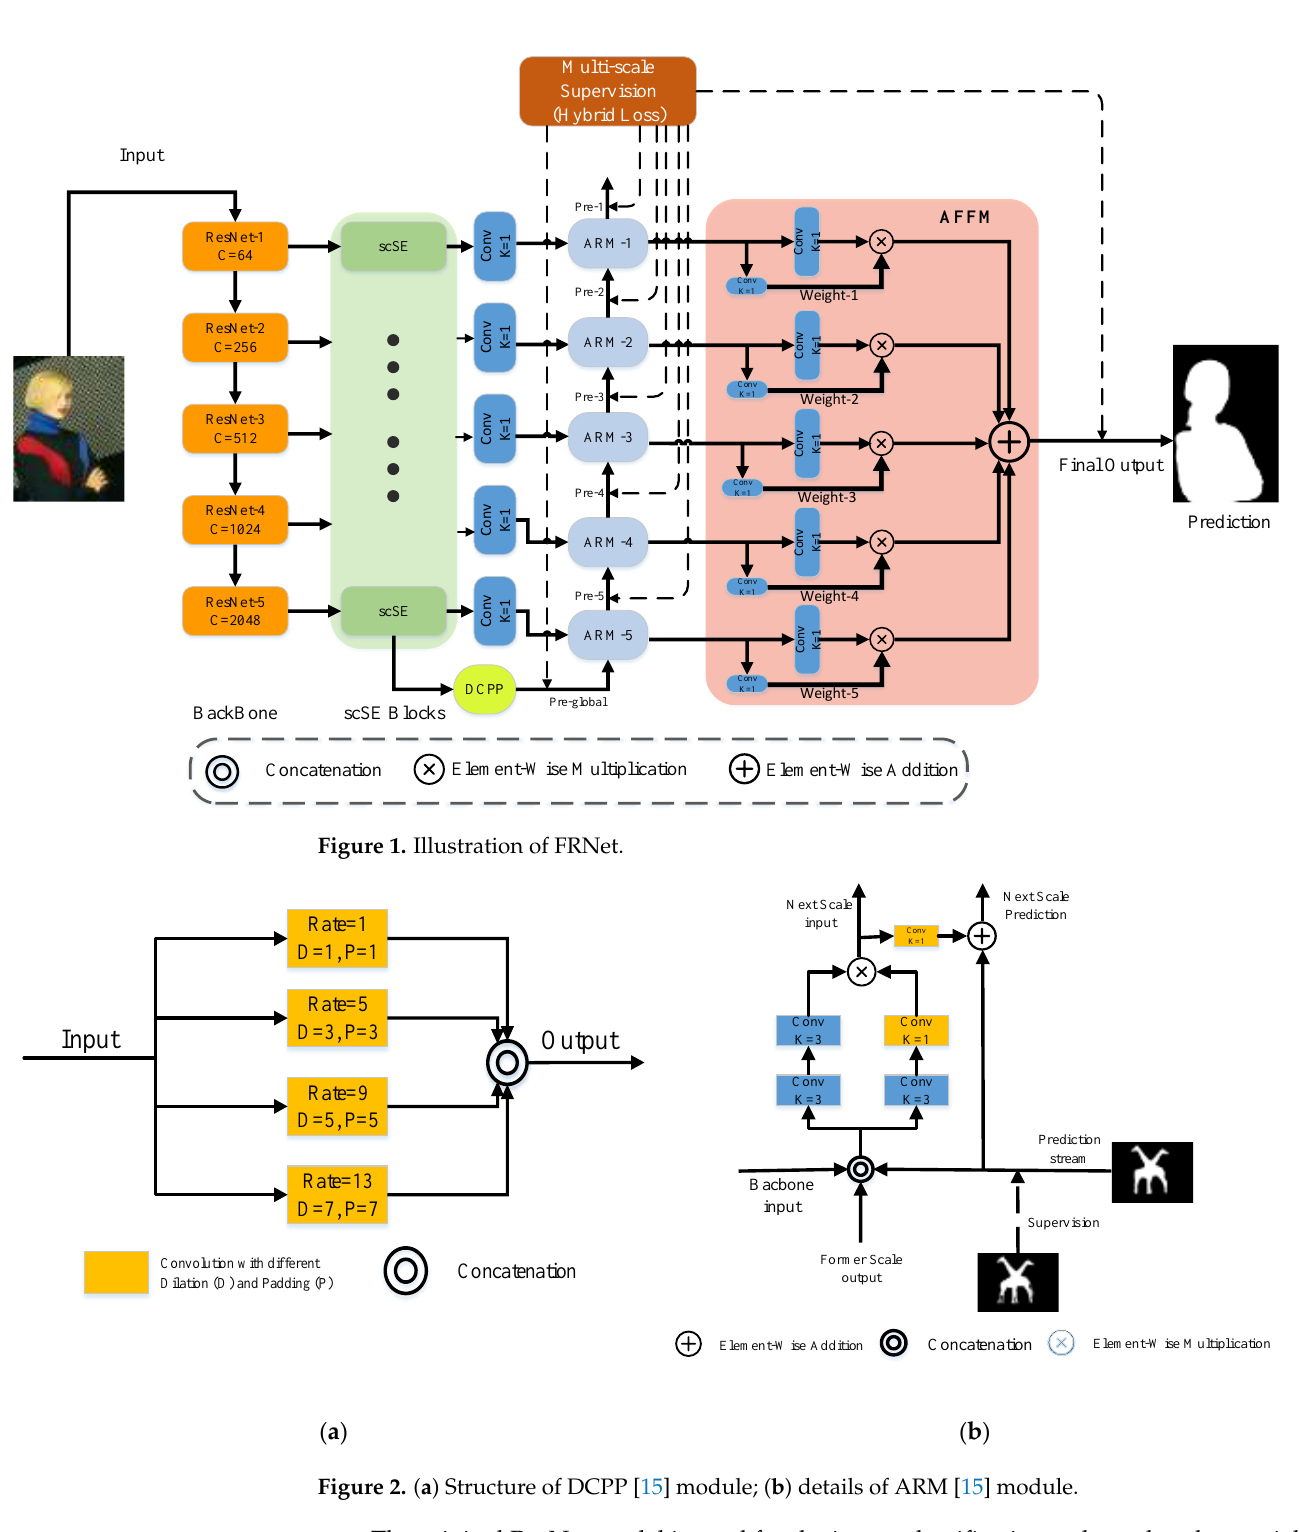
(1) the full connection layer of the ResNet model for image classification is removed. (2)